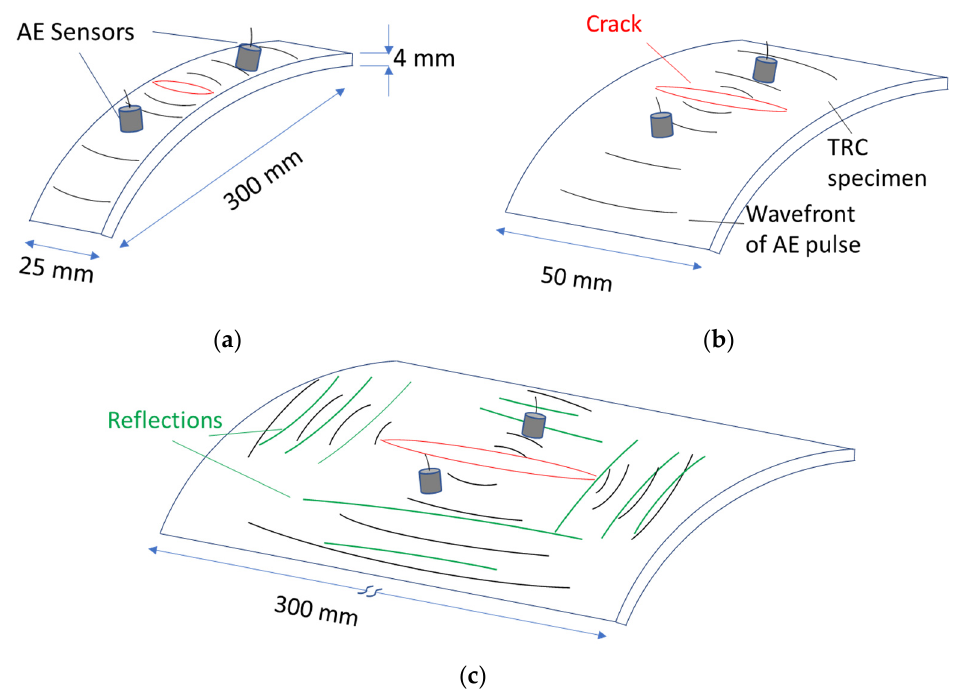
Figure 2. Schematic representation of AE in curved plates with different widths. Corresponding to ( a ) a beam of 25 mm width ( b ) a beam of 50 mm width, ( c ) plate with 300 mm width.